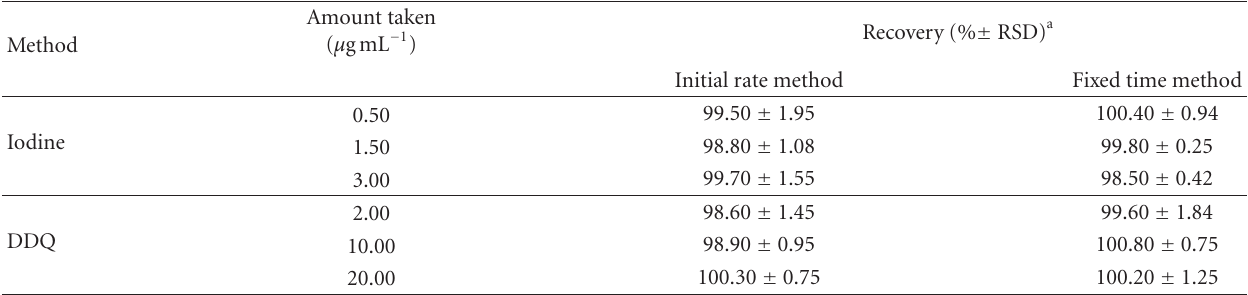
Table 5: Evaluation of the accuracy of the proposed initial rate and fixed time methods for determination of OMZ.